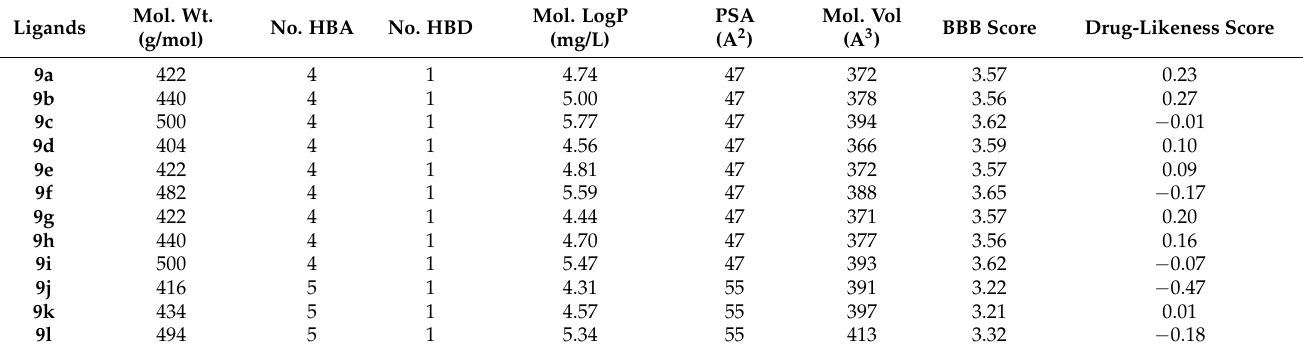
Table 2. Chemo-informatics analysis of the designed chemical compounds 9(a–i)